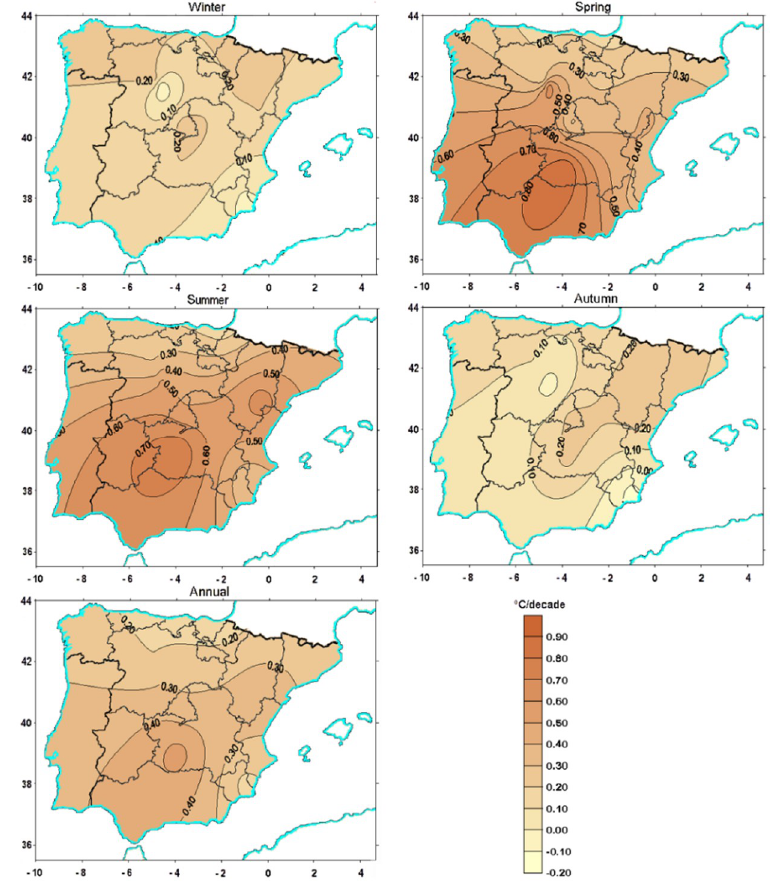
Figure 3. Isolines of seasonal and annual trends in maximum temperature anomalies in Spain over the period 1950–2011, expressed in °C decade -1 .